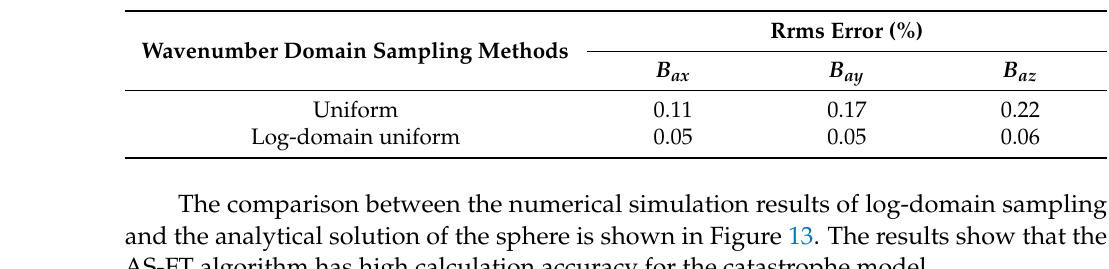
Figure 12. Spectral distribution of weak magnetic field in wavenumber domain (z = 250 m). Table 4. Accuracy statistics of different sampling points between − 0.1 and 0.1 in the wavenumber